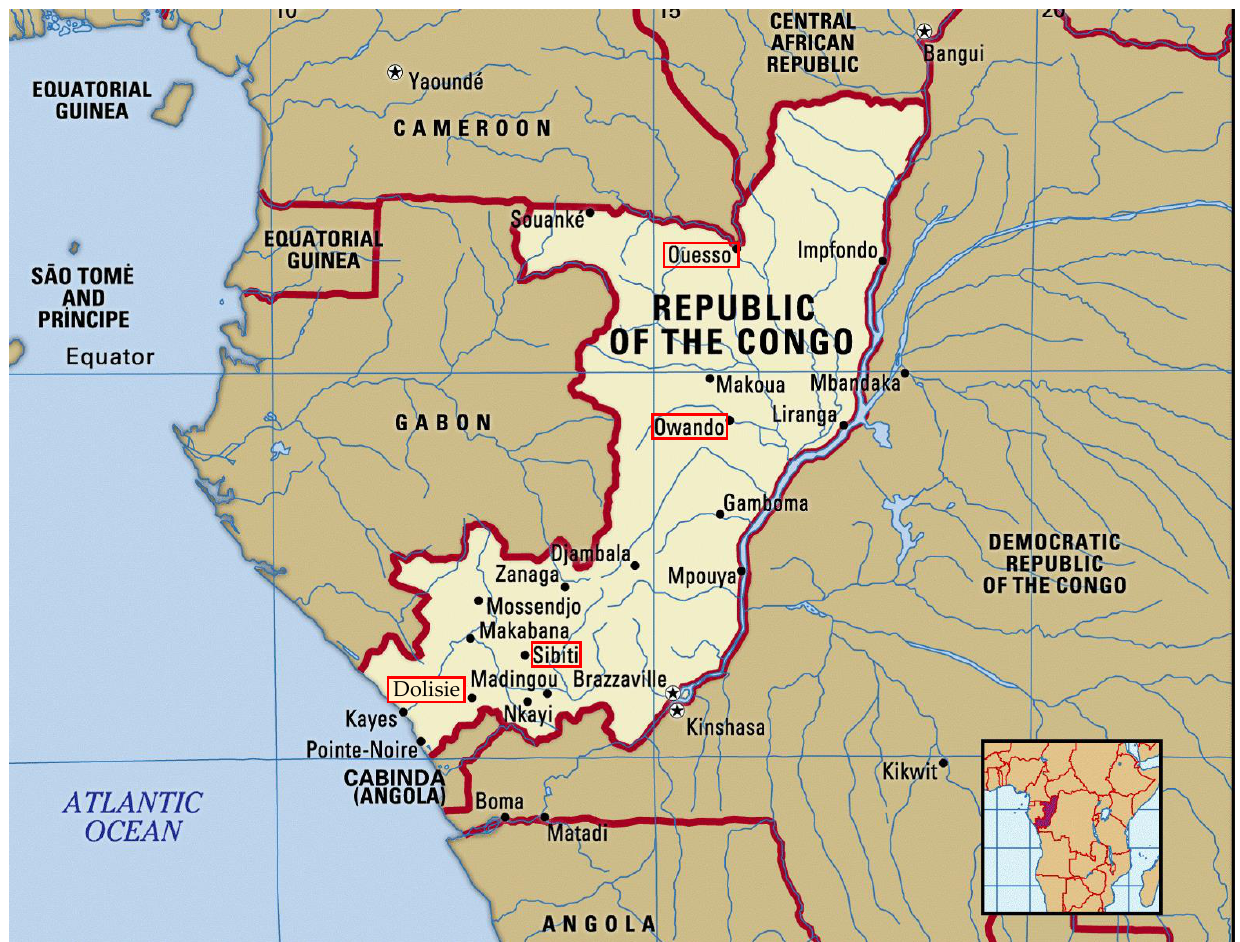
Figure 1. Map of the Republic of the Congo indicating the four localities of the study: Ouesso, Owando, Dolisie and Sibiti.